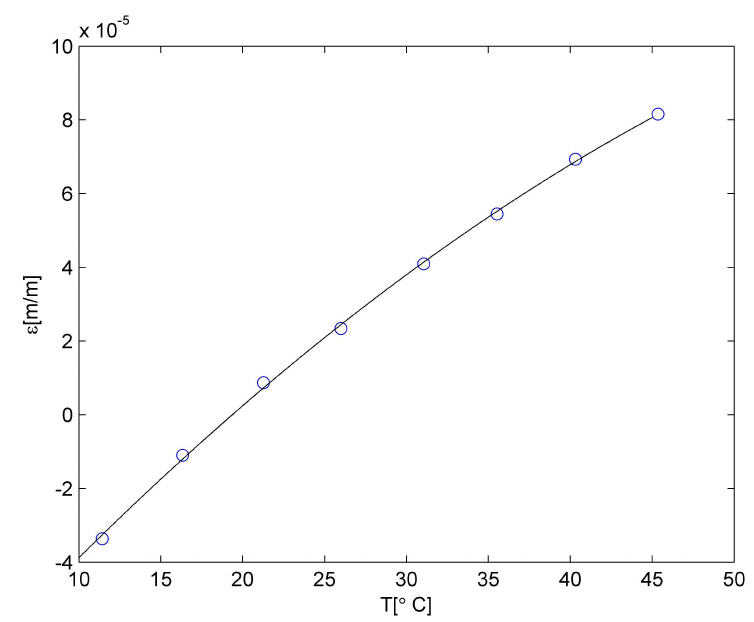
Figure 7. Relationship between strain and temperature for CFRP samples.